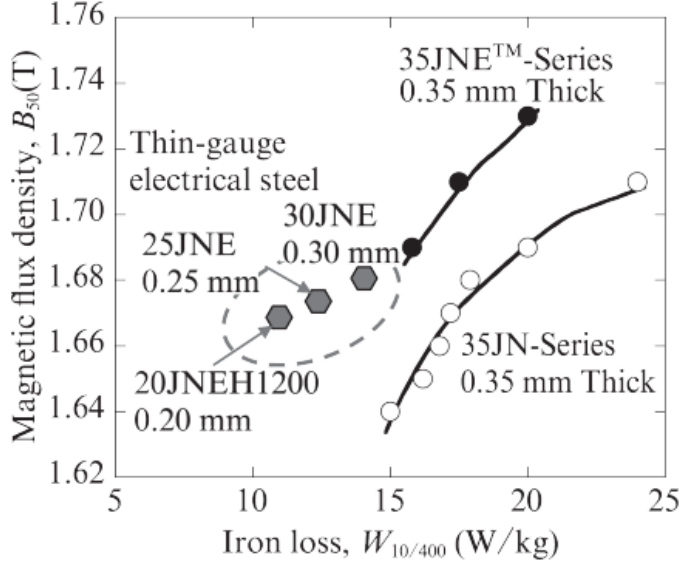
Figure 14. Core losses of the 20JNEH1200 steel material used in the stator [33].